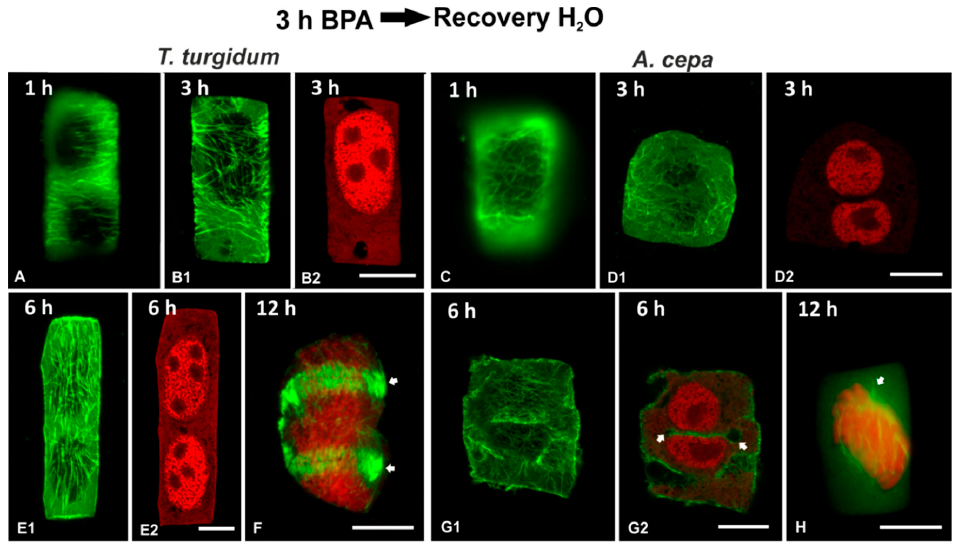
Figure 11. Tubulin immunolocalization (green, A , B1 , C , D1 , E1 , F , G1 , H ) and propidium iodide DNA staining (red, B2 , D2 , E2 , F , G2 , H ) in root cells recovering after BPA treatment for duration noted on the figures. Arrows in ( F ) point to an atypical phragmoplast, while arrows in ( G2 ) point to cell plate remnant in a post-cytokinetic cell. Images ( D1 , F , H ) are maximum projections of CLSM sections, while the rest of the images are single CLSM sections. Scale bars: 10 μ m.